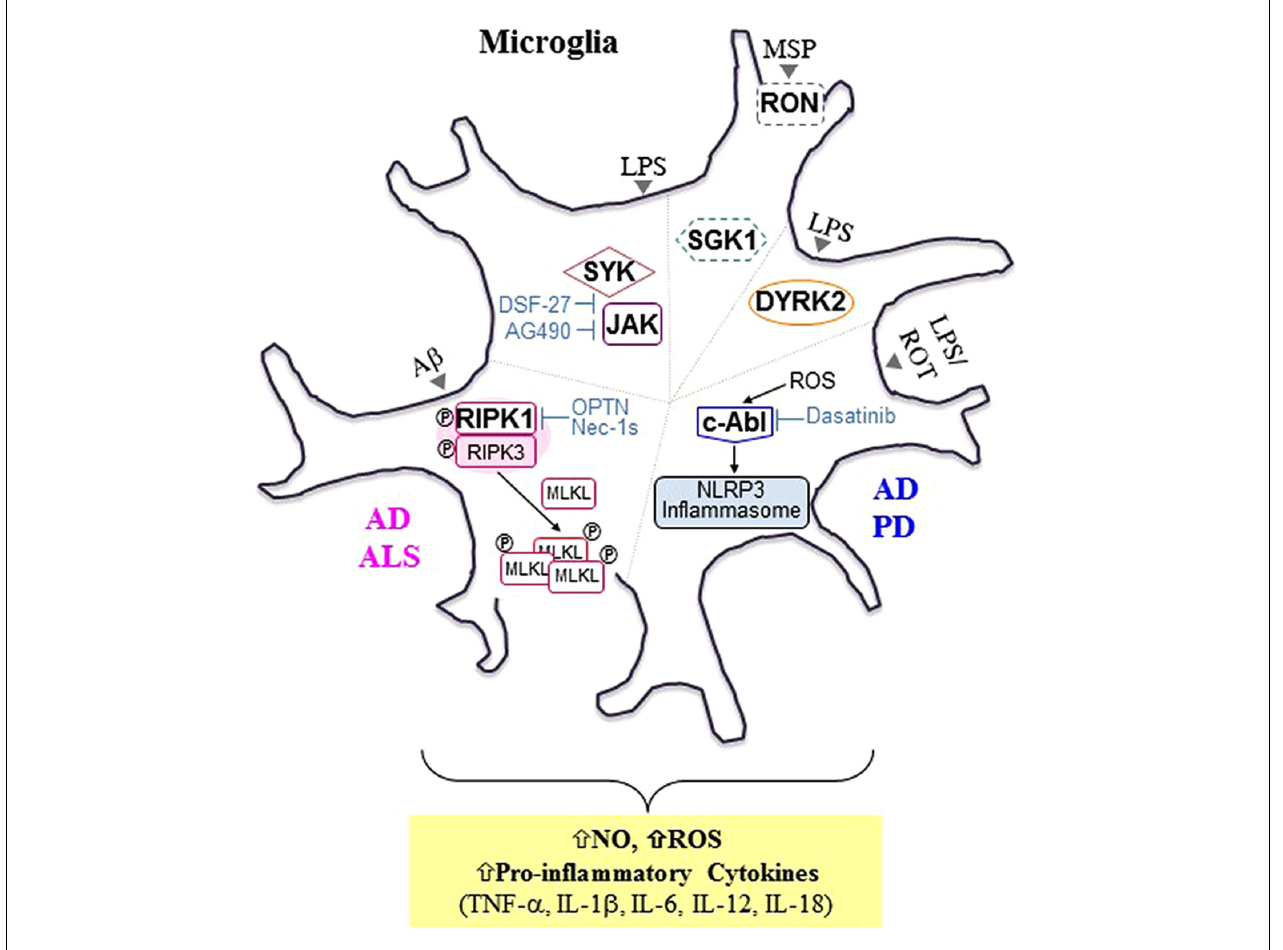
FIGURE 1 | Selected microglial protein kinases involved in microglia-mediated neuroinflammation and neurodegenerative diseases. In addition to progressive neuronal damage and death, it is now evident that chronic neuroinflammation mediated by microglia is another common hallmark shared by neurodegenerative diseases such as Alzheimer’s disease (AD), Parkinson’s disease (PD), and amyotrophic lateral sclerosis (ALS). Selected protein kinases (PKs) involved in microglia-mediated neuroinflammation are presented here, and these PKs can be targeted to tame microglial phenotypes favorable for disease-modifying treatments. In general, activated receptor interacting protein kinase 1 (RIPK1), a serine (Ser)/threonine (Thr) PK, interacts with and phosphorylates RIPK3, forming a RIPK1/RIPK3-containing complex, which is known as a “ripoptosome.” Activated RIPK3, in turn, recruits and phosphorylates mixed lineage kinase domain-like protein (MLKL), promoting MLKL oligomerization and subsequent translocation into the plasma membrane, leading to direct pore formation and the initiation of necroptosis. In animal models of AD [APP/ PS1 transgenic mice] and ALS [optineurin (Optn) knockout mice (KO) and mSOD G93A mice], activated RIPK1 (either by A β 1 − 42 peptide or by the presence of Optn KO or mSOD G93A ) mediates inflammatory responses rather than necroptosis in microglia (Ito et al., 2016; Ofengeim et al., 2017). In addition, axonal myelination defects were observed in ALS mouse models and elevated levels of hallmarks of necroptosis were detected in microglia in postmortem cortical samples from AD patients. Treatment with Nec-1s, a highly selective and central nervous system-permeable RIPK inhibitor, was demonstrated to inhibit microglia-mediated inflammation (Ito et al., 2016). Reactive oxygen species (ROS) derived from oxidative stress were found to activate nucleotide oligomerization domain (NOD)-like receptor protein (NLRP3) inflammasome via cellular Abelson murine leukemia viral oncogene homolog 1 (c-Abl) activation, resulting in the release of primarily interleukin (I β )-1b and IL-18 (Lawana et al., 2017). Treatment of microglia with dasatinib, a dual c- Abl/c-Src kinase inhibitor, was demonstrated to inhibit NLRP3-mediated release of pro-inflammatory factors including IL-1b β , IL-18, ROS, nitric oxide (NO), and tumor necrosis factor- α (TNF- α ). A strong correlation between inflammasomes and neurological disorders including AD, PD, and multiple sclerosis (MS) has been implicated in many recent studies (Lang et al., 2018). Both spleen tyrosine kinase (SYK) and Janus kinase (JAK), intracellular tyrosine (Tyr) PKs were also found to be associated with microglia-mediated neuroinflammation upon lipopolysaccharide (LPS) stimulation (Zeng et al., 2014). DSF-27, a novel sesquiterpene dimmer isolated from the medicinal plant, Artemisia argyi , was demonstrated to inhibit LPS-induced activation of SYK and JAK signaling pathways, resulting in a reduction in TNF- α , IL-1 β , IL-6, and NO levels. Treatment with AG490, a specific inhibitor of JAK2, was found to inhibit LPS-induced NO production (Inoue et al., 2016; Asai et al., 2018). Dual-specificity tyrosine phosphorylation-related kinase 2 (DYRK2) is an intracellular Ser/Thr kinase localized in both the nucleus and the cytoplasm. It was demonstrated to translocate to the nucleus and interact with multiple kinases downstream of LPS stimulation, thereby regulating the production of pro-inflammatory molecules such as TNF- α and IL-1 β . Unlike the other kinases presented here, the basal activity of both Receptor D’Origine Nantais (RON) and serum- and glucocorticoid-inducible kinase 1 (SGK1), boxed with the dotted line, were demonstrated to be involved in the anti-inflammatory process in microglia. RON, a receptor tyrosine kinase, is activated by its ligand, macrophage-stimulating protein (MSP), resulting in the promotion of anti-inflammatory responses and subsequent tissue repair (Dey et al., 2018). SGK1, an intracellular Ser/Thr kinase, was found to inhibit LPS-induced activation of microglia. A β , amyloid beta; ROT, rotenone; APP, Amyloid Precursor Protein; PS1, Presenilin 1; Nec-1s, necrostatin-1s.